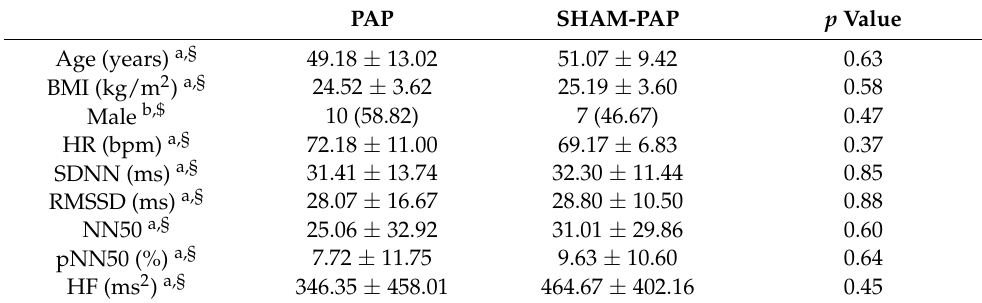
Table 1. Baseline values of PAPIMI (PAP) and Sham PAPIMI (SHAM-PAP) groups.